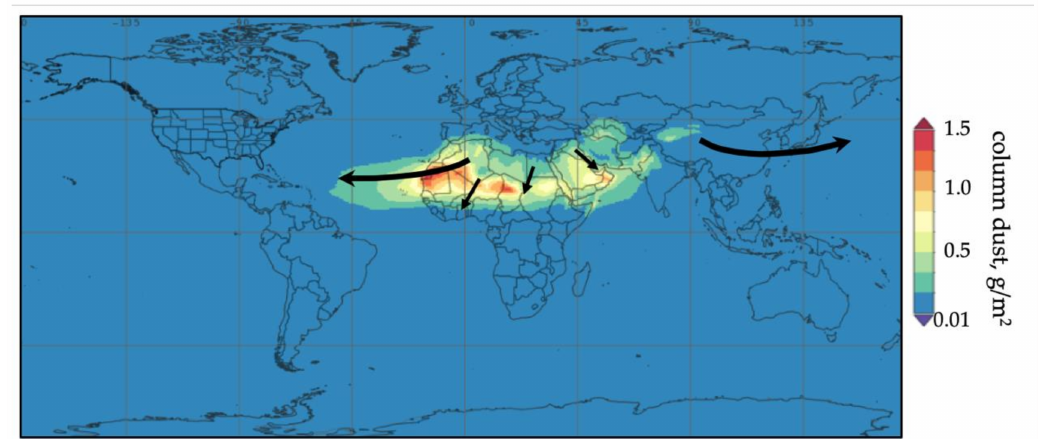
Figure 1. Global mean summer distribution of atmospheric dust according to MERRA-2model. The black arrows indicate the main dust transport